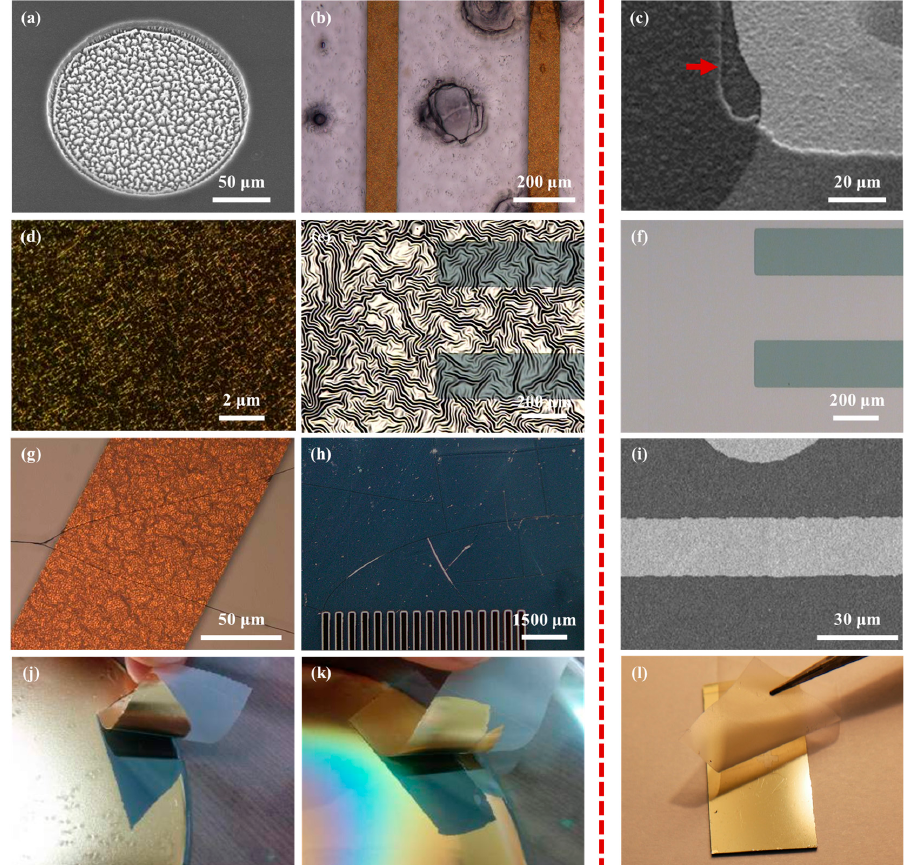
Figure 5. Comparison of fabrication process results with PDMS layer (the left of the red dotted line) and PDMS–parylene hybrid layer (the right of the red dotted line). ( a ) PDMS residues after dry etching; ( b ) PDMS dissolution; ( c ) Well-patterned parylene layer after dry etching. The red arrow shows the edge of etched parylene layer; ( d ) The surface of metal deposited on the PDMS surface damaged by excessive oxygen plasma treatment; ( e ) Metal film wrinkles by thermal expansion on PDMS layer; ( f ) Metal layer on PDMS–parylene hybrid layer after thermal treatment; ( g ) Cracks of the ( h ) Cracks of photoresist film on PDMS layer by thermal expansion; ( i ) Well-patterned metal